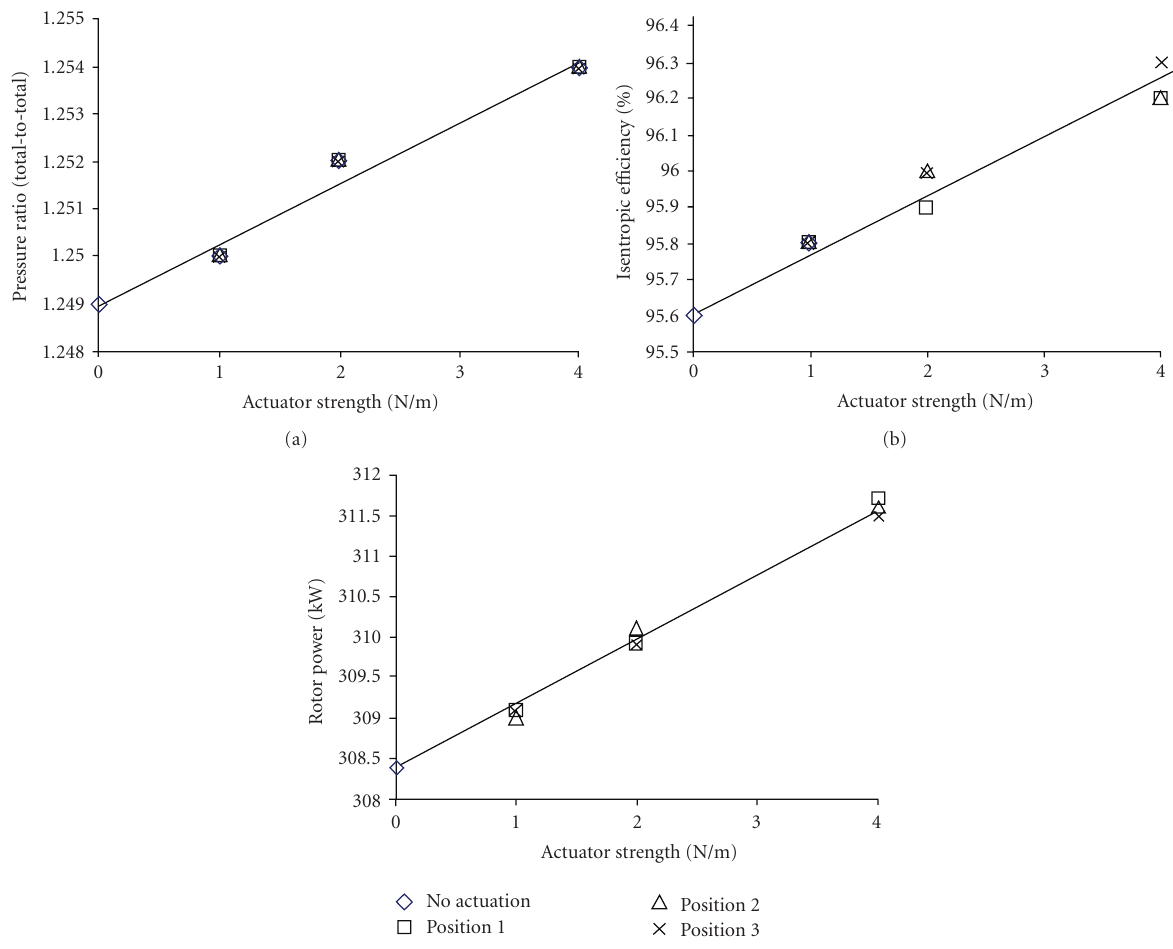
Figure 11: E ff ect of actuator strength and position on compressor performance for steady actuation.